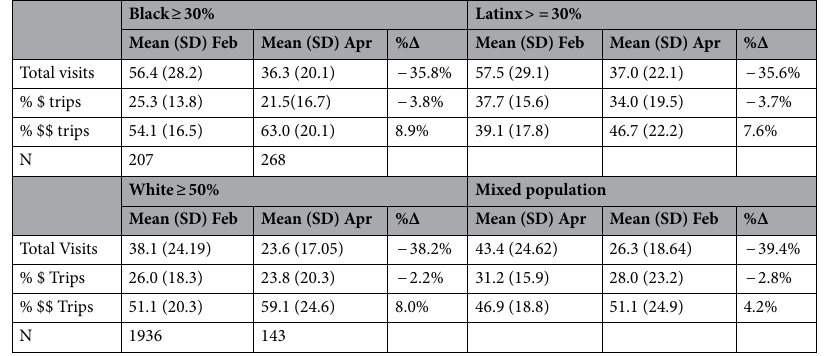
Table 1. Descriptive statistics for total visits to grocery stores and distribution across types of grocery stores in February and April 2020, split by ethnic composition of neighborhood. 2,453 CBGs in metro Boston with population > 200 residents. Categorization by ethnicity is imperfect, as 56 CBGs had both > = 30% Black and Latinx residents (13% of all CBGs with > = 30% of either group) and 45 CBGs with majority White population had > = 30% Black or Latinx residents (11% of all CBGs with > = 30% of either group). Mixed population is all CBGs not reaching any of the three thresholds.